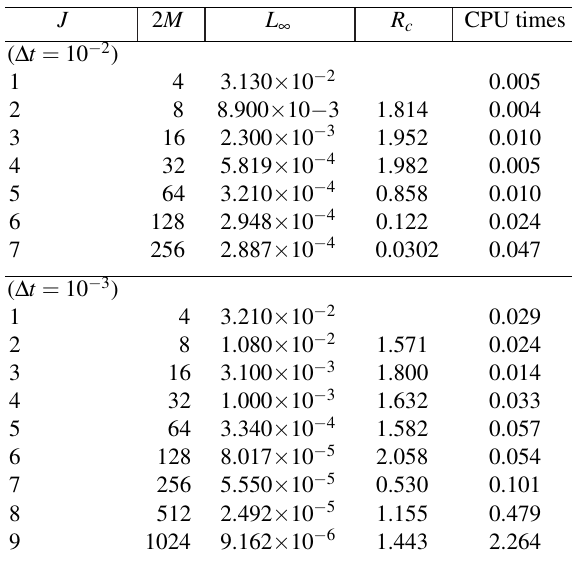
Table 7. Numerical results at t = 1 for Test Problem 9